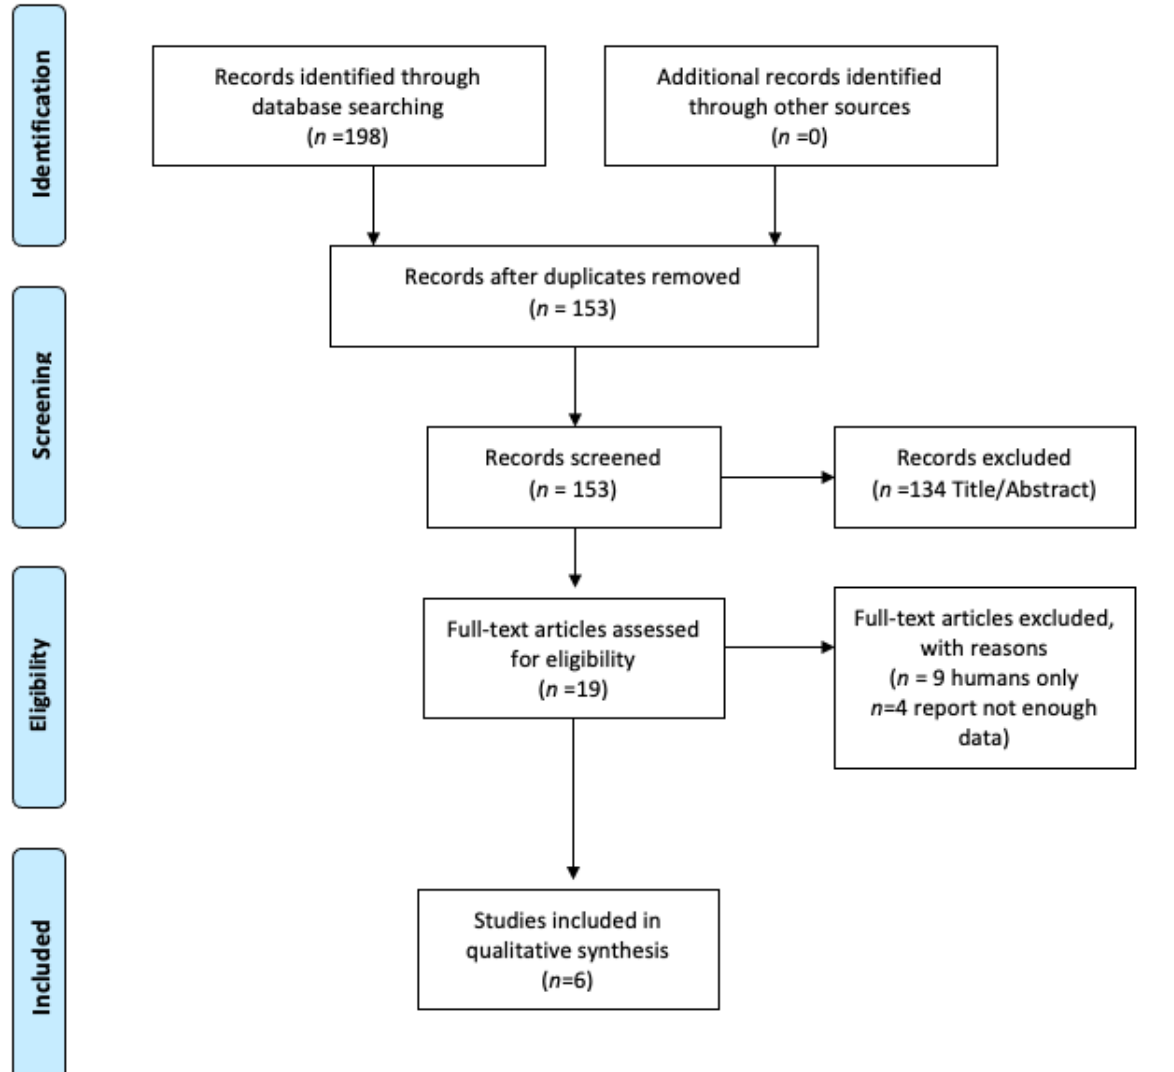
Figure 1. Flow chart of the databases search on influence of probiotics/synbiotics administration on gut microbiota in patients with colorectal cancer (CRC).